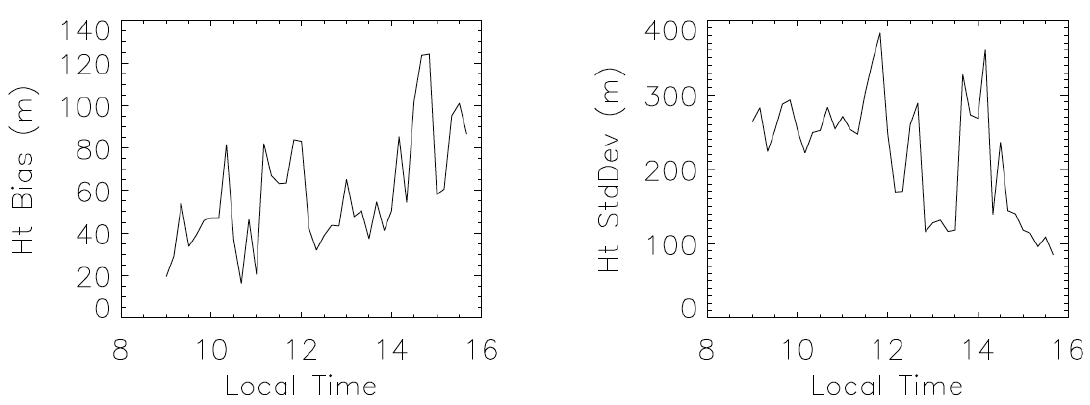
Figure 31. Local time dependence of the terrain height bias ( left ) and its standard deviation ( right ) in the Southwest U.S. (111° W–105° W, 32° N–38° N) from the 3D-wind Band 2 retrievals for 26 July 2019.